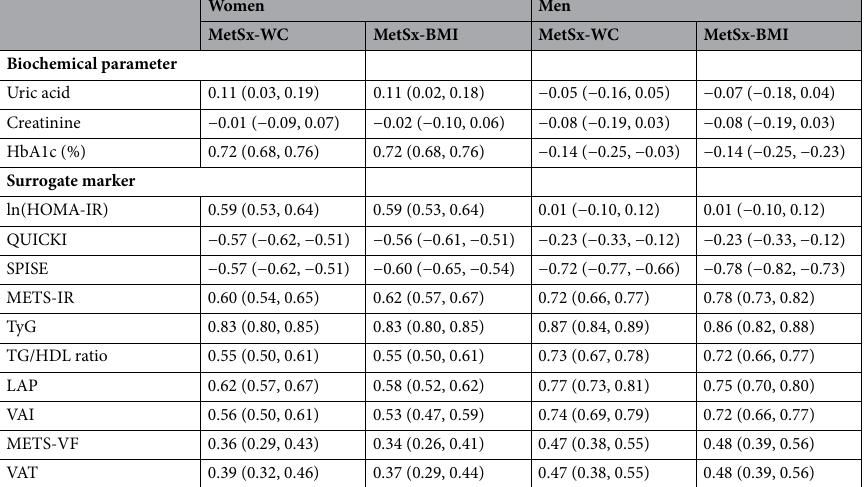
Table 6. Correlations (95% CI) of biochemical parameters and surrogate markers with the